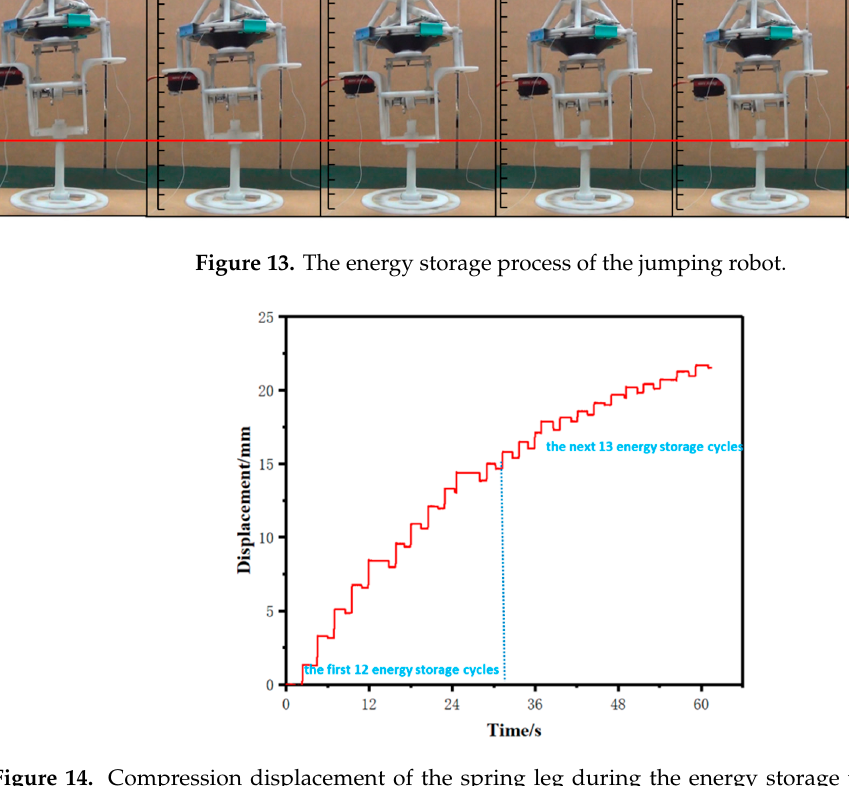
Figure 14. Compression displacement of the spring leg during the energy storage process of the jumping robot.